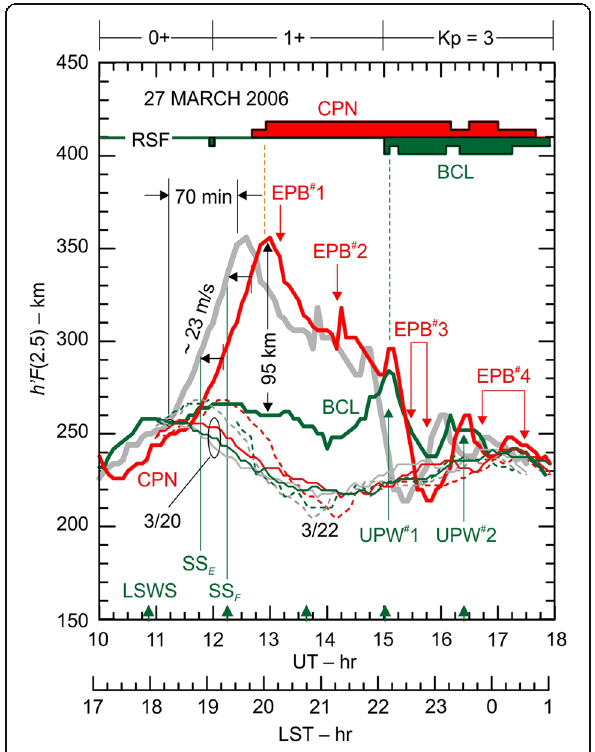
Fig. 10 Curves of h ’ F (2.5) vs UT, for two quiet nights (20 and 22 March 2006), and one disturbed night (27 March 2006). The green (red) curve is for BCL (CPN). The gray curve is h ’ F (2.5) vs LST for CPN. Two levels for range type of ESF are shown, weak and strong; they should be used with the UT scale. Mean SSN for 2006 was